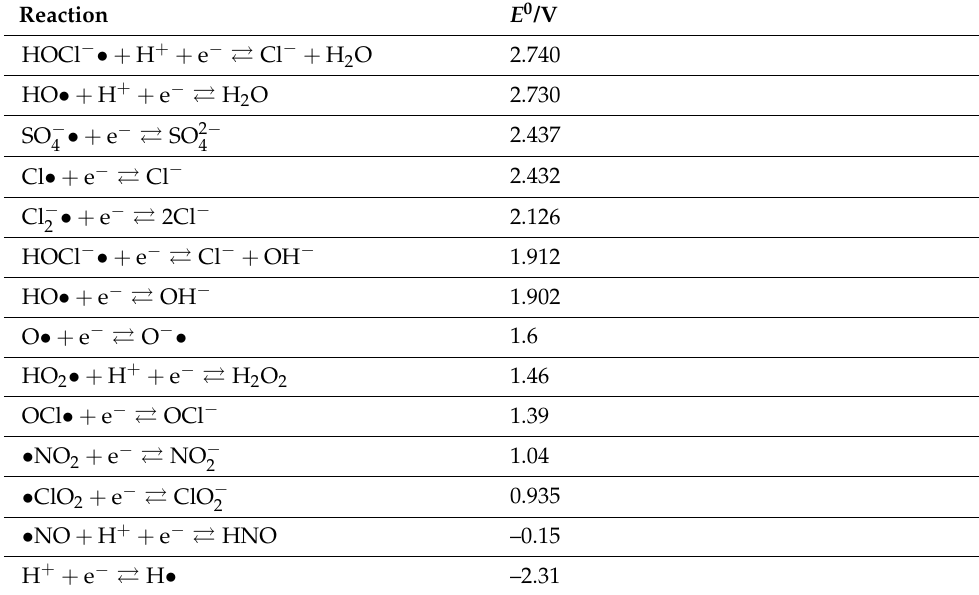
Table 1. Standard redox potentials ( E 0 ) of the most common radical species encountered in AOP treatments